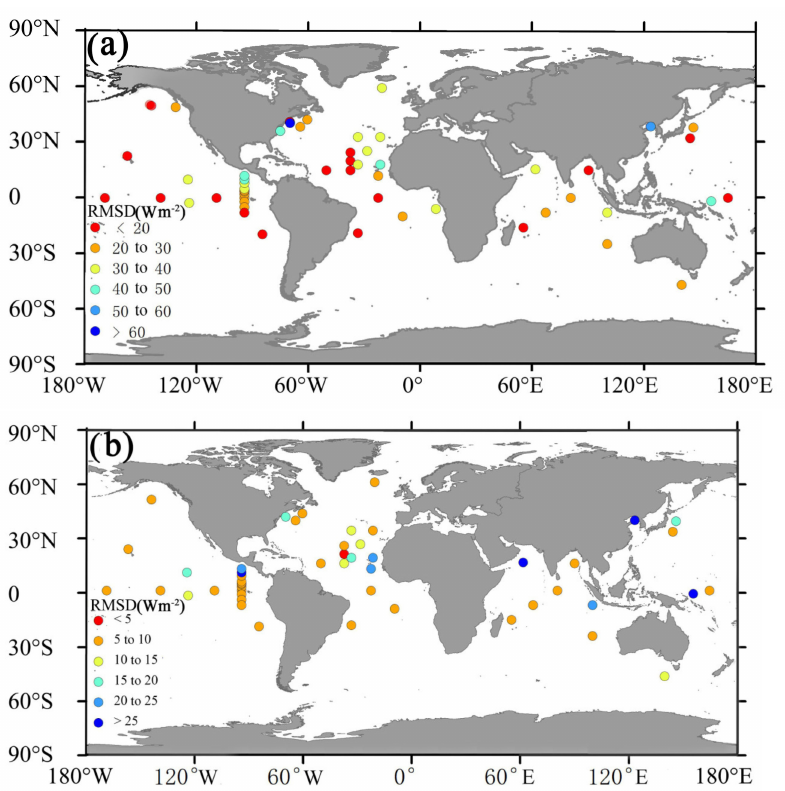
Figure 5. Spatial distribution of the RMSD of the J-OFURO3 sea-surface R n data at individual site at ( a ) daily and ( b ) monthly scales.